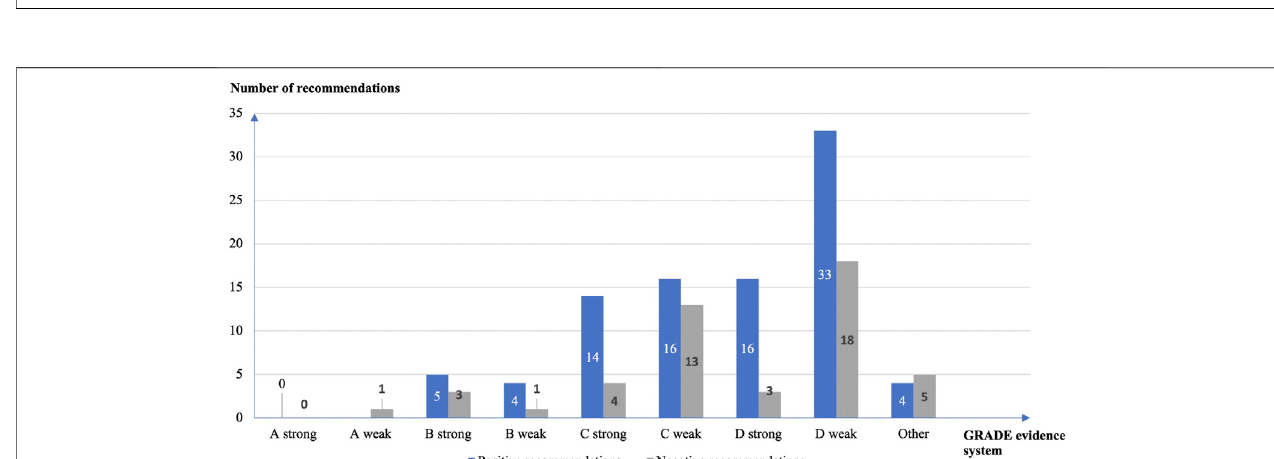
FIGURE 2 | The types of references cited to support the recommendations.